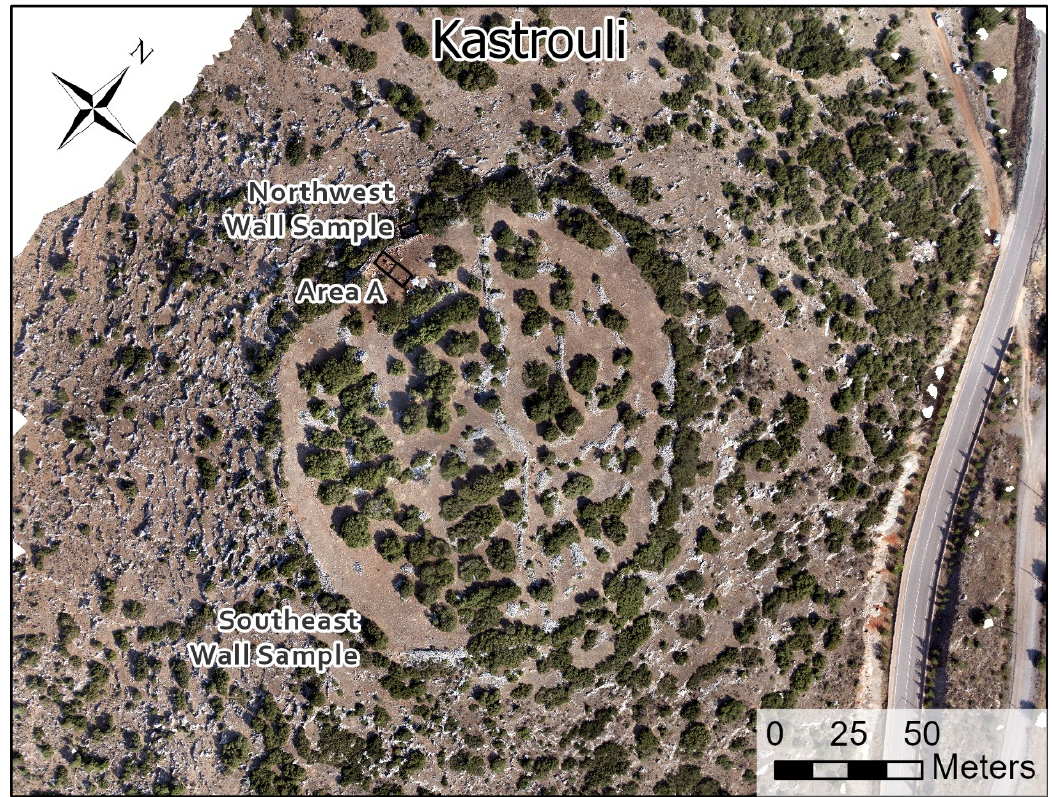
Figure 1. An orthophotograph of the site of Kastrouli, Greece. Note the vegetation obscuring the ground surface across the site.